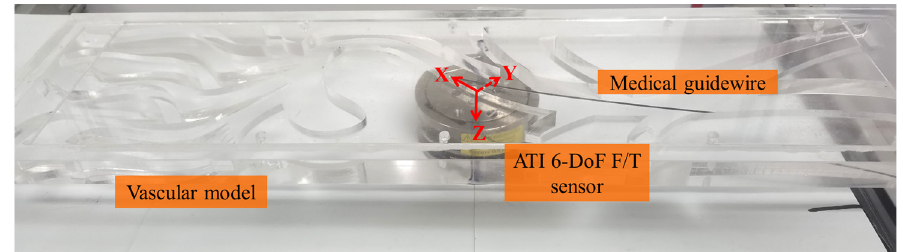
Figure 7. The configuration of the 6-DoF F/T sensor to acquire the contact forces generated from the interaction between intravascular tools and the vasculature.